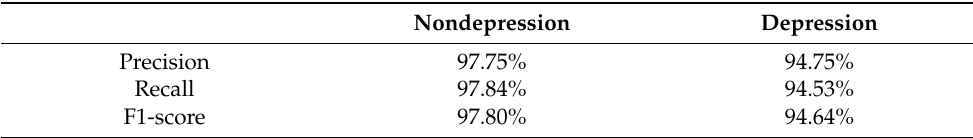
Table 6. Classification performance for the binary classification in Setting